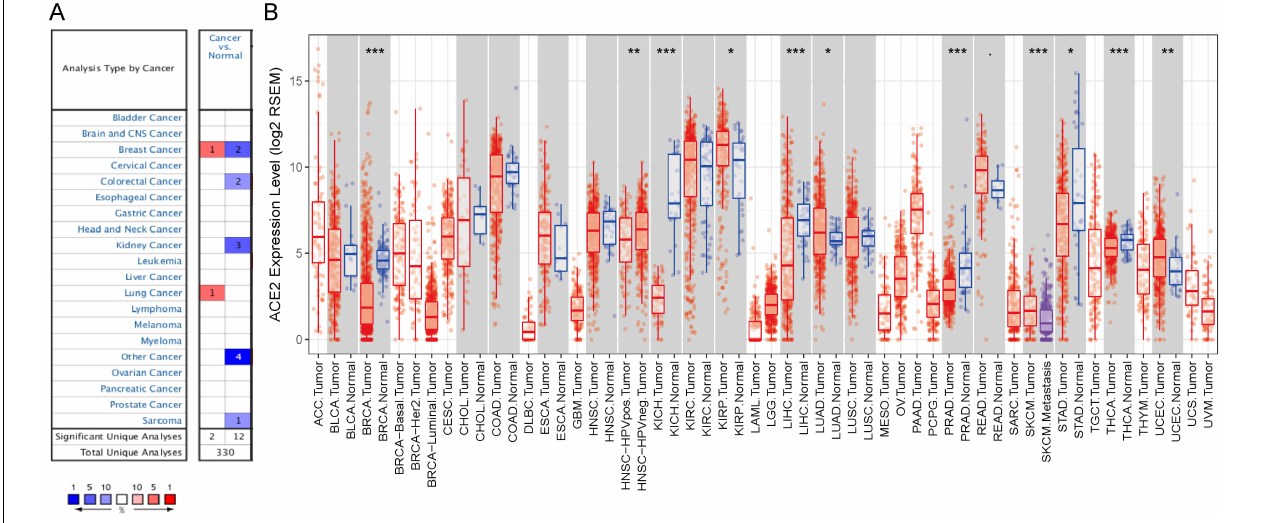
FIGURE 1 | ACE2 expression levels in cancers. (A) Increased or decreased expression of ACE2 in different cancer tissues, compared with normal tissues in Oncomine. Number in each cell is the amounts of datasets. (B) Human ACE2 expression levels in different cancer types from TCGA data in TIMER ( < 0.1, * P < 0.05, ** P < 0.01, *** P <